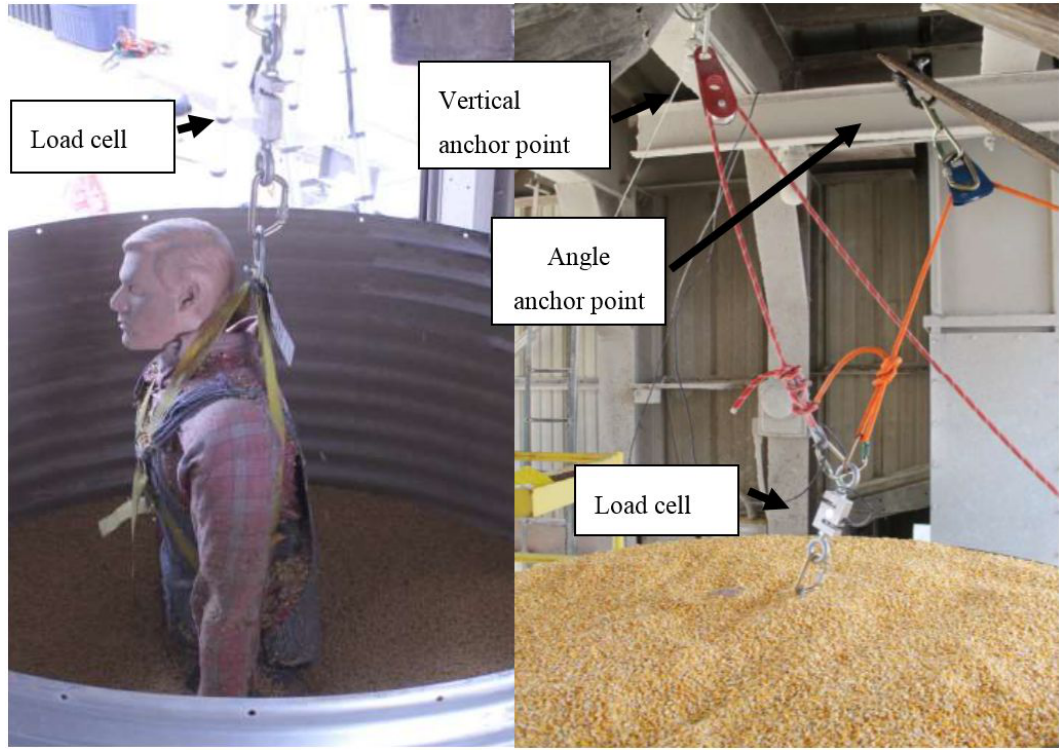
Figure 2. Mannequin setup for experiment shown on the left. On the right, the mannequin is fully engulfed in grain and tied to two lines for vertical pull and angle pull.